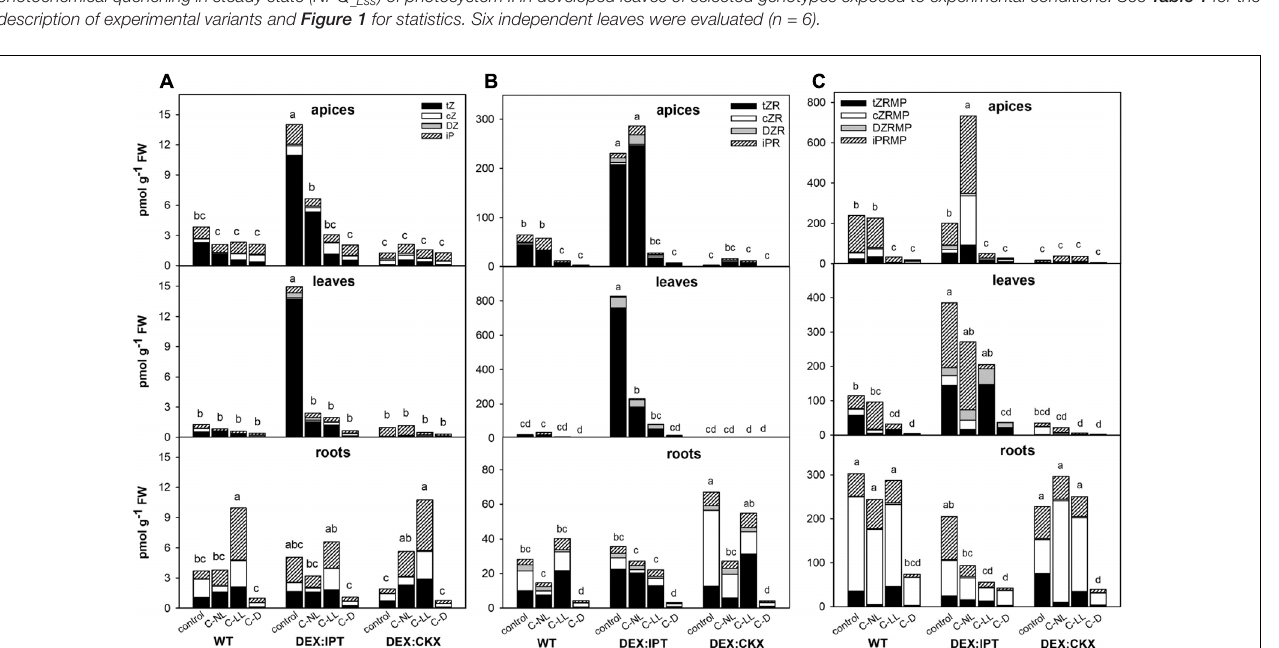
monophosphate (tZRMP) was preserved in apices under